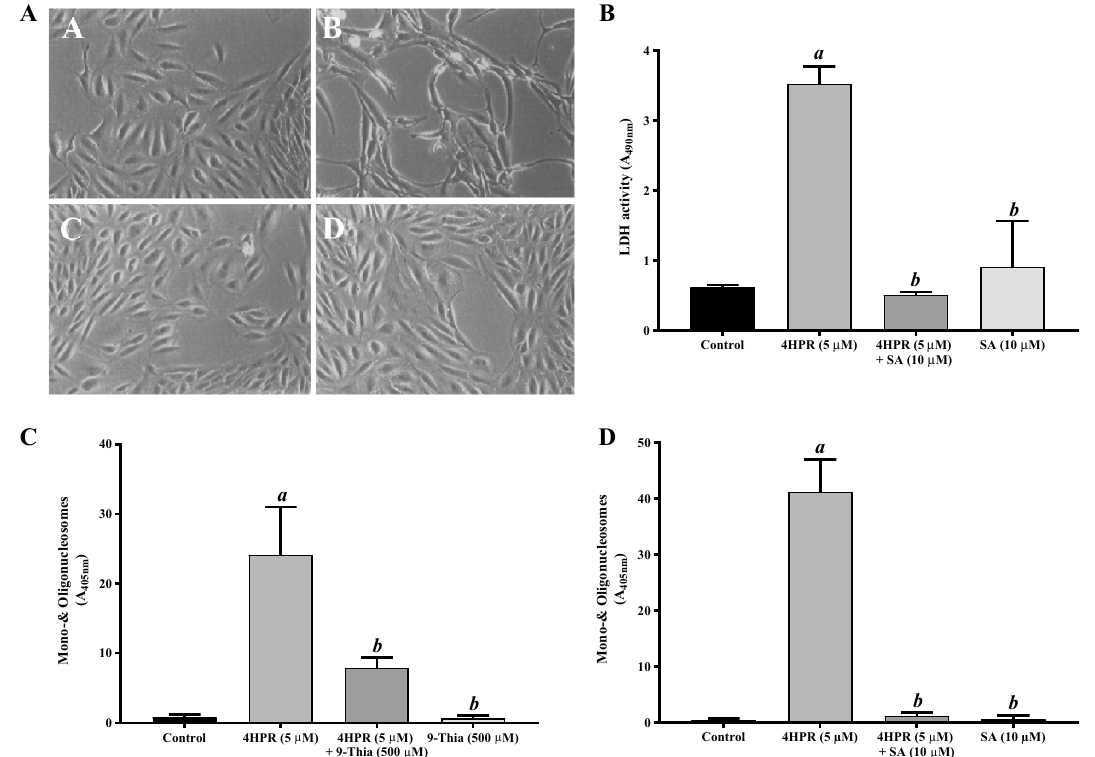
Figure 1. Fenretinide-induced cell death of human ARPE-19 cells is prevented by pretreatment with sterculic acid (SA), an inhibitor of SCD. Panel A , phase-contrast micrographs of ARPE-19 cells treated with 5 μM fenretinide (4HPR) in the presence or absence of SA for 24 h. ( A) Subconfluent cells 2 days after plating. ( B ) Cells treated with 4HPR for 24 h. ( C) Cells treated with 4HPR in the presence of SA. ( D ) Cells treated with SA alone. Magnification ×100. Panel B, Inhibition of fenretinide-induced LDH release from ARPE-19 cells by SA. Panel C , Inhibition of fenretinide-induced apoptosis by SCD inhibitor 9-Thia-stearate. Panel D, inhibition of fenretinide-induced apoptosis by SA. ARPE-19 cells were treated with 5 μM fenretinide in the presence or absence of the indicated SCD inhibitors for 24 h, then analyzed by apoptosis ELISA as described under “Experimental Procedures”. The values are mean ± SD of three independent experiments performed in quadruplicate. To test for significant differences between treatment groups, one-way analysis of variance (ANOVA) was used. In the graphs ‘ a’ indicates statistical significance difference between fenretinide treated and untreated control, and ‘ b’ indicates statistical significance difference between fenretinide and fenretinide treated with inhibitors, and inhibitors alone ( a , b p <